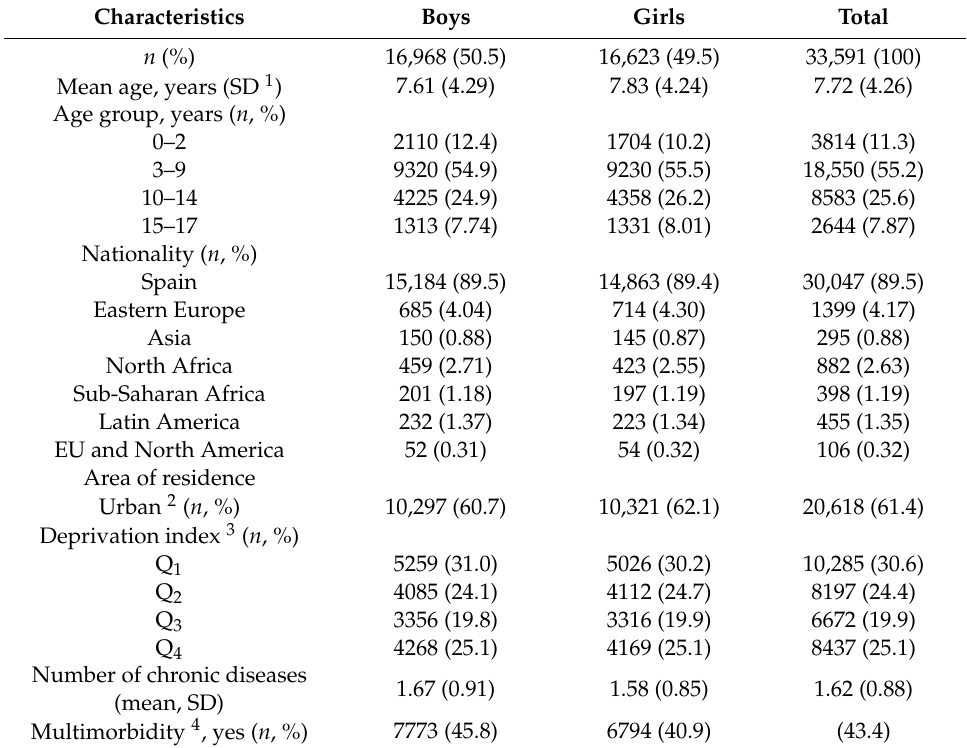
Table 3. Socio-demographic and clinical characteristics of children of the EpiChron Cohort aged 0–17 years with atopic dermatitis in